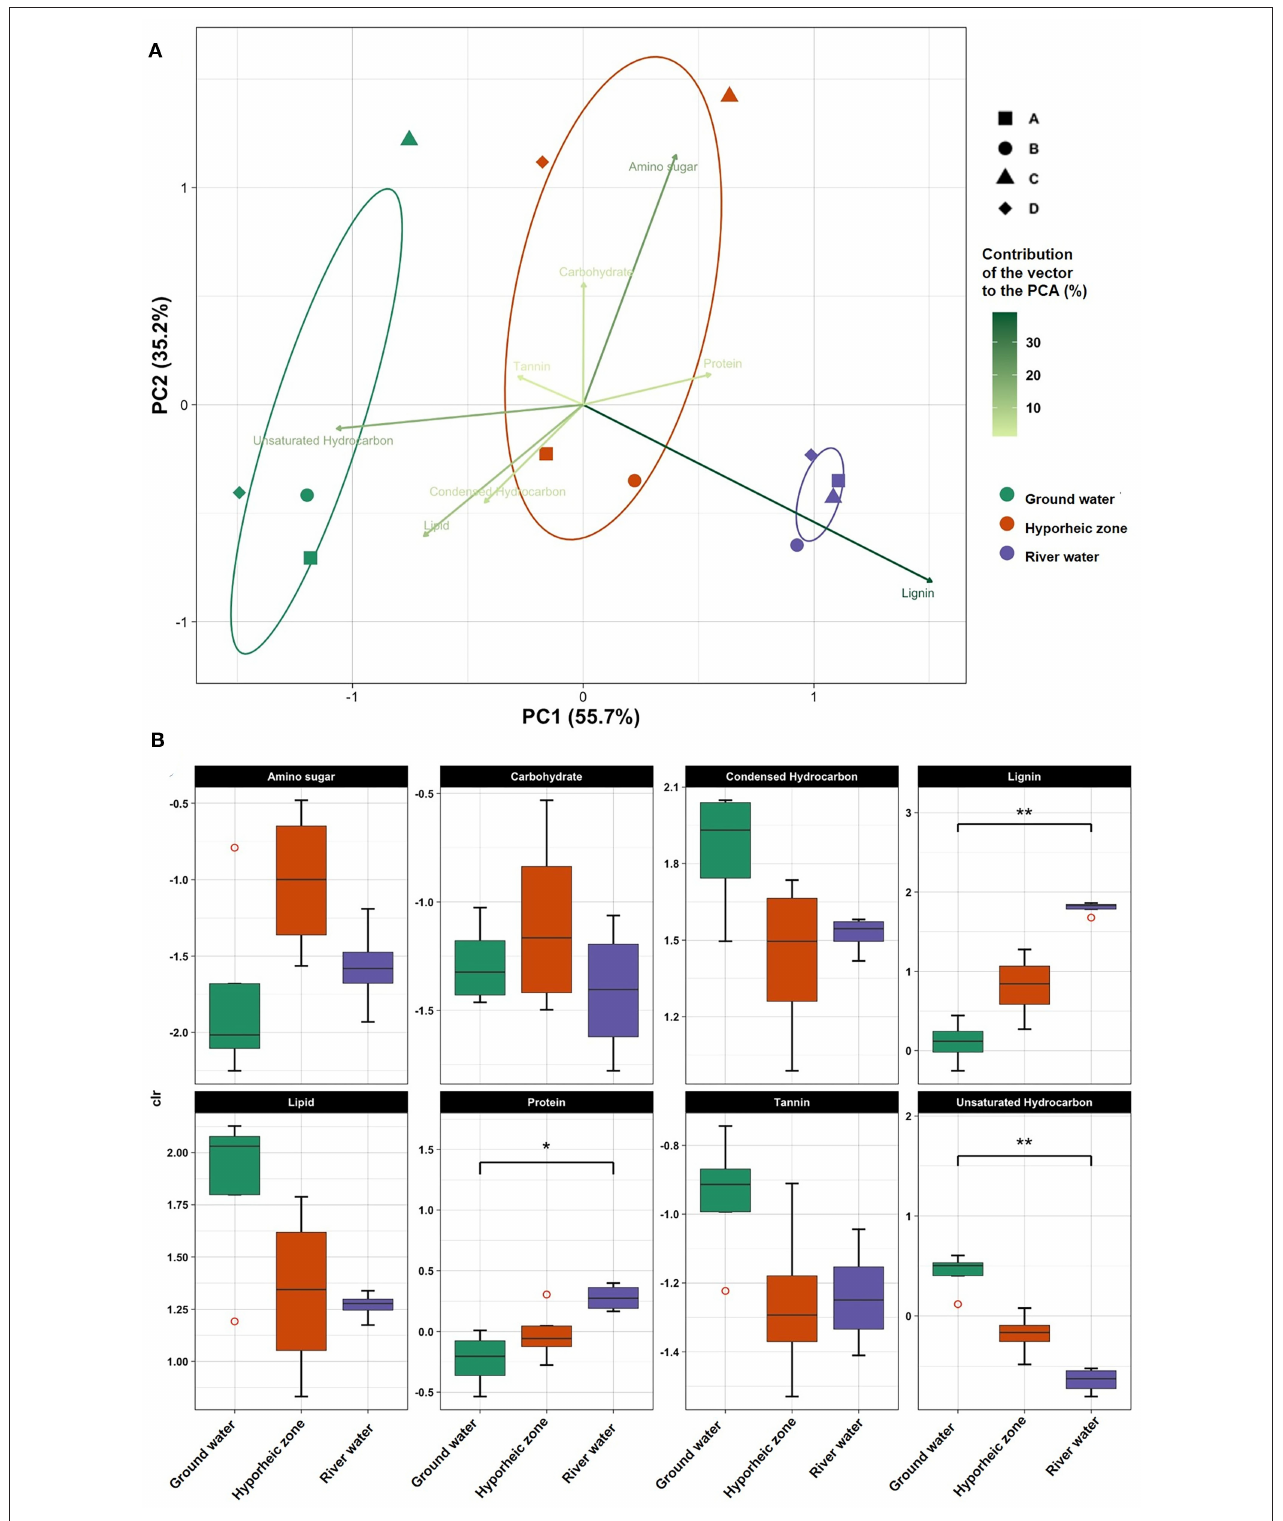
FIGURE 2 | (A) Principle component analysis (PCA) on centered log ratio (CLR) transformed chemical class abundances in each system (ground water, hyporheic, and river water) at four-time intervals (A–D) (i.e., different river level stages) in November 2013; (B) Box plots of CLR transformed chemical class abundances in each system (ground water, hyporheic zone, and river water). Dunn post-hoc tests were performed between ecosystem and chemical class composition to visualize the statistical significance (represented by an *if p < 0.05 and **if p < 0.001).